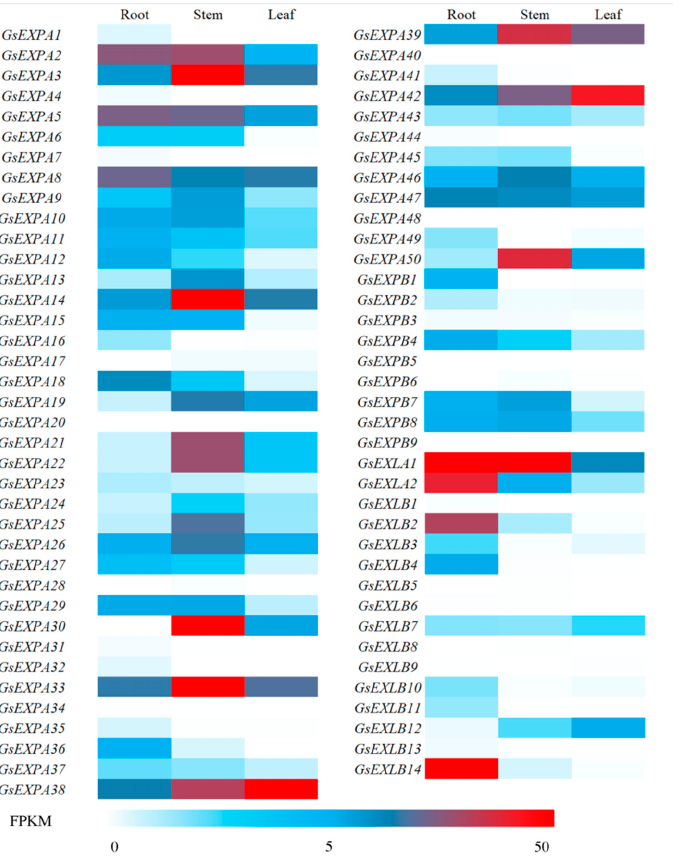
Figure 6. Heatmap of wild soybean expansins expression levels in vegetative organ transcriptome. FPKM, fragments per kilobase of transcript per million fragments mapped.